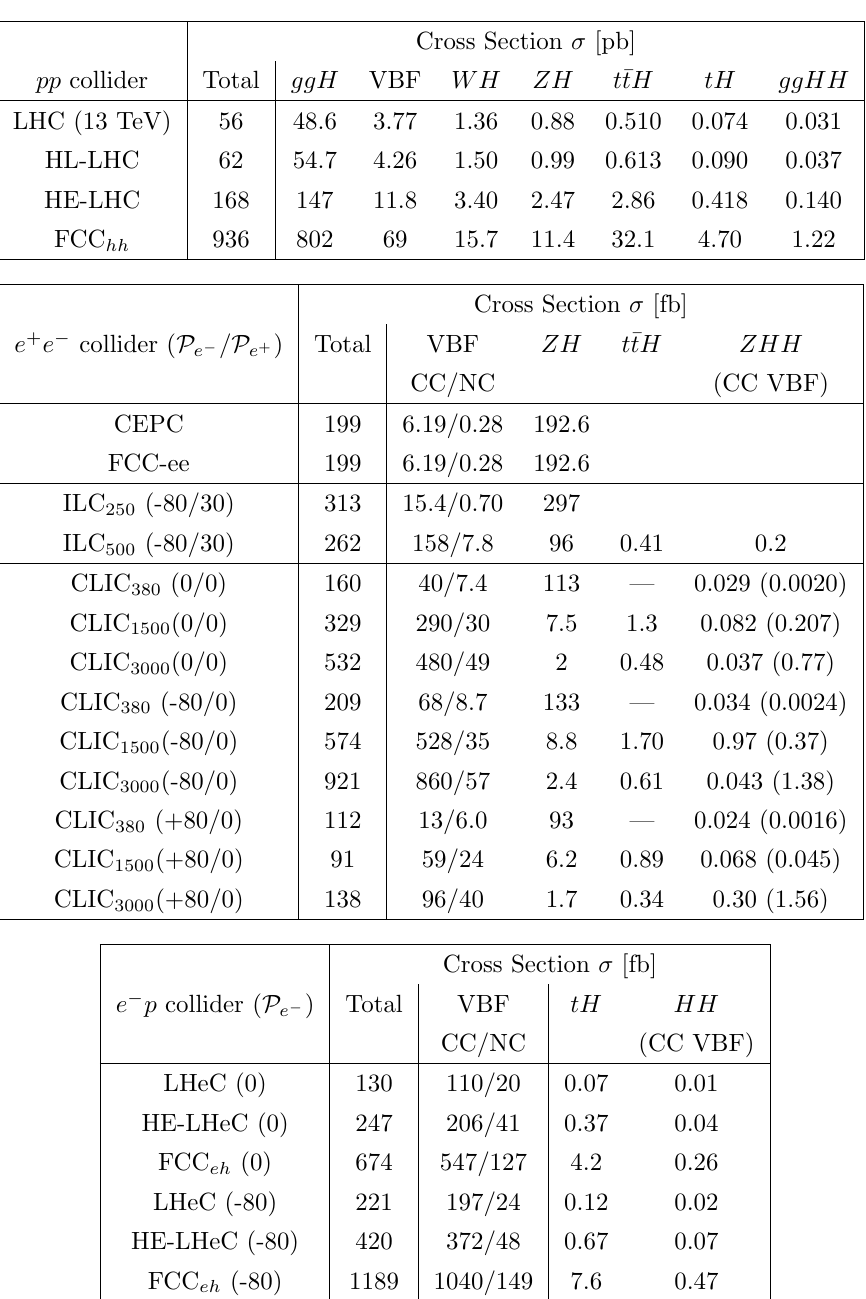
Table 18 . Cross sections for the main production channels expected for Higgs boson production at the di(cid:11)erent types of colliders (as de(cid:12)ned in table 1).